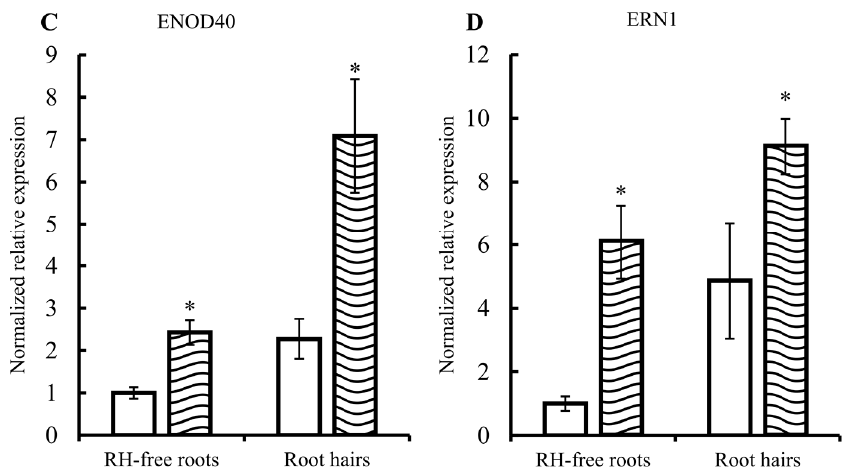
Figure 1. Validation of the common bean root hairs (RH) single-cell system. Relative expression of ( A ) Actin 11 , ( C ) ENOD40 , and ( D ) ERN1 . In C and D , white and striped histograms represent the mean of expression values from mock-induced and nodulation factors (NF)-induced samples, respectively. Expression values are normalized to the value of the control of RH-free roots that was set to 1. Error bars represent the standard error of the mean of the relative expressions from three biological replicates. Mann-Whitney statistical test: * p < 0.05, ** p < 0.01; and ( B ) microscopic images showing RH from mock-induced control roots (CT: Control, top ) and from NF-induced roots (NF: NF-induced, bottom ). Scale bars: 100 µm.